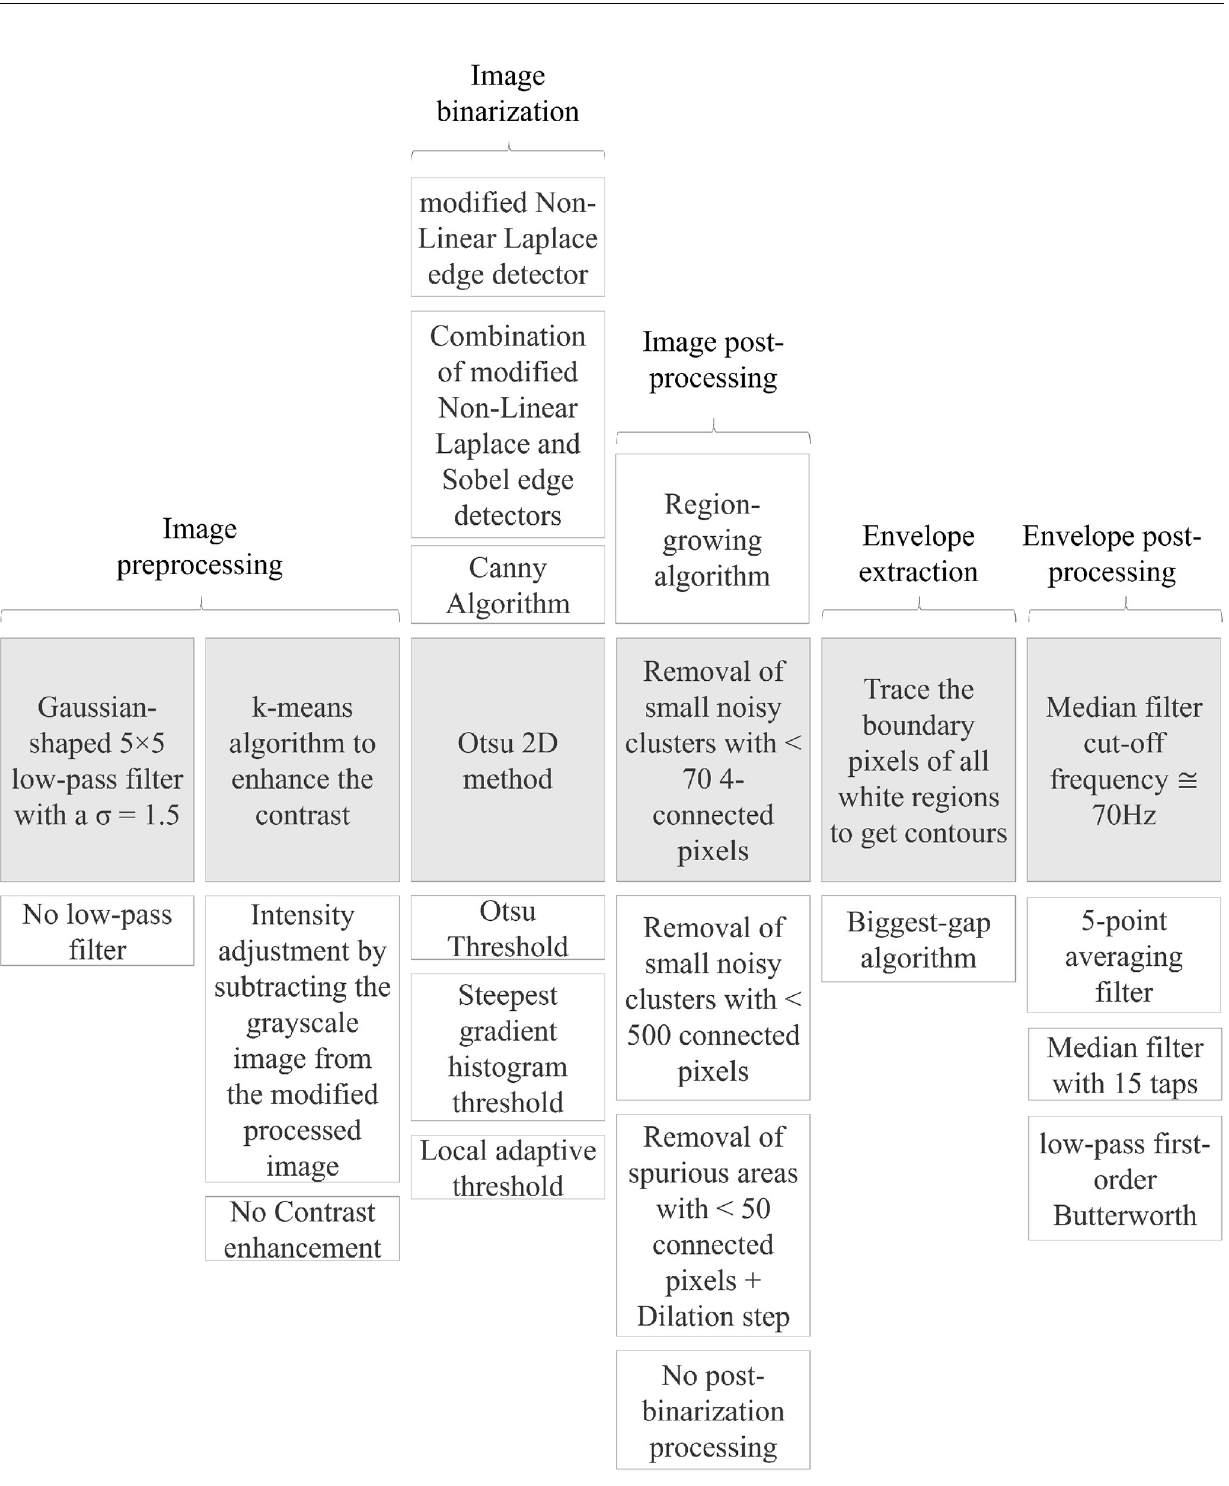
Fig 3. Envelope tracing workflow. Columns show the different processing steps in the workflow for tracing the Doppler velocity envelope. The shaded boxes in the center row indicates the chosen main work chain and the remaining indicate the available options from the state-of-the-art algorithms evaluated in this